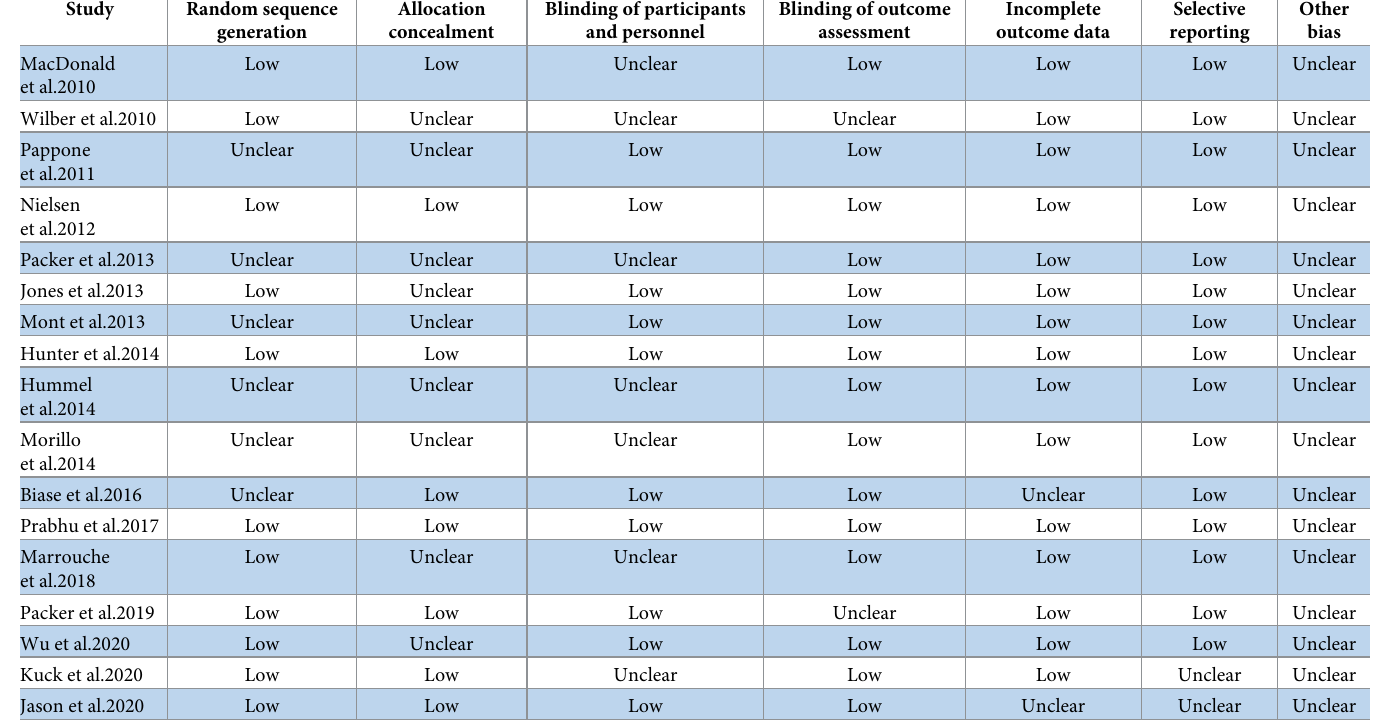
Table 4. Risk of bias